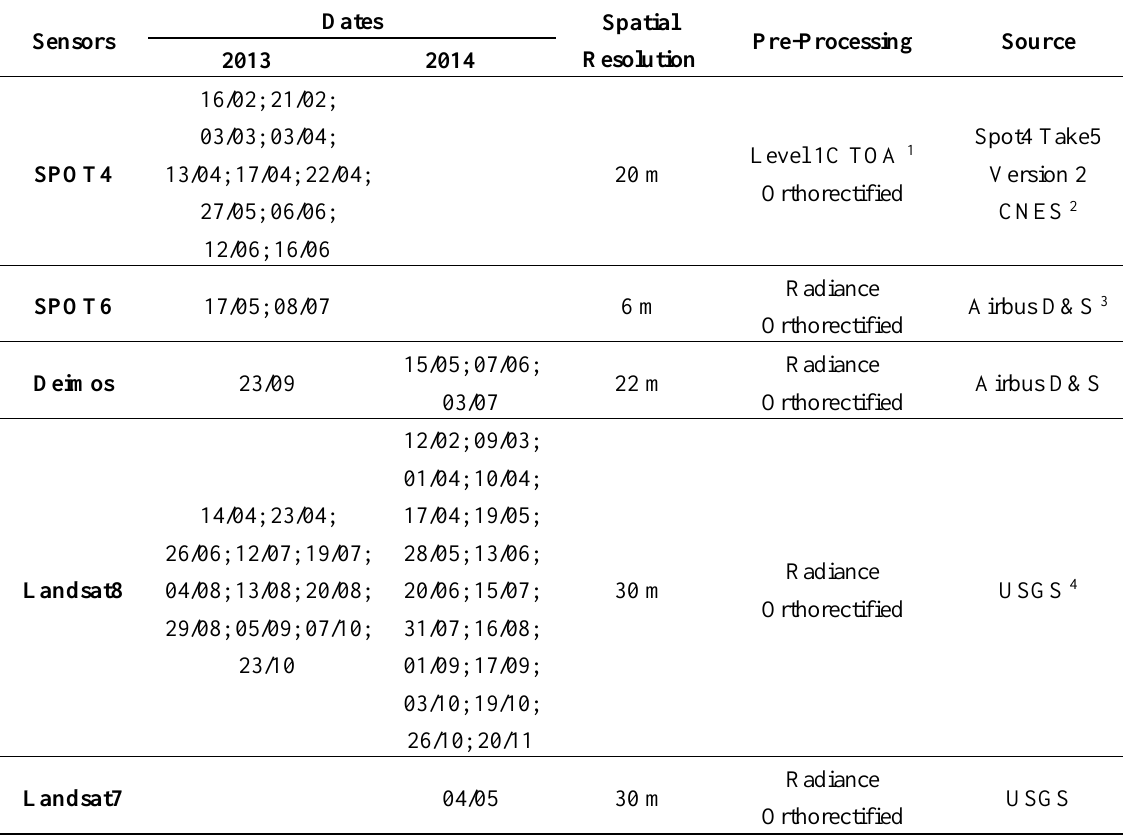
Table 1. List of the high resolution images processed for the computation of the Forage Production